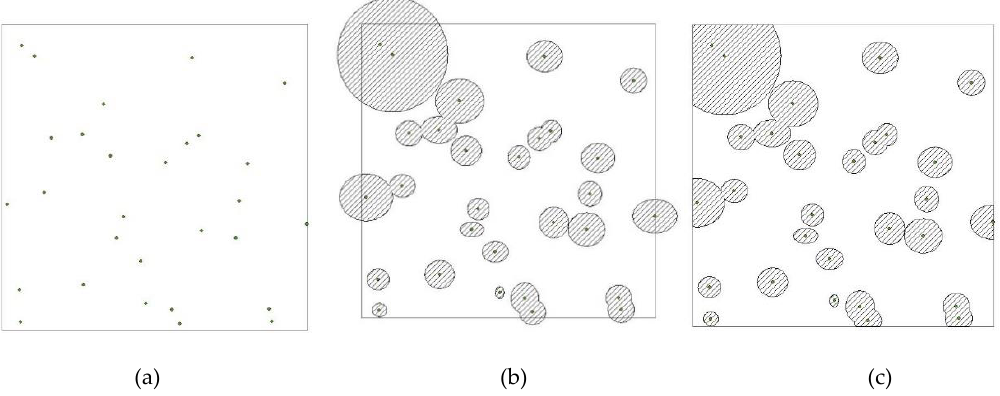
Figure 2. Canopy cover per plot, which was determined by the tree location and crown diameter in NS and WE direction ( a ) tree location ( b ) tree canopy cover area ( c ) canopy cover in a plot.